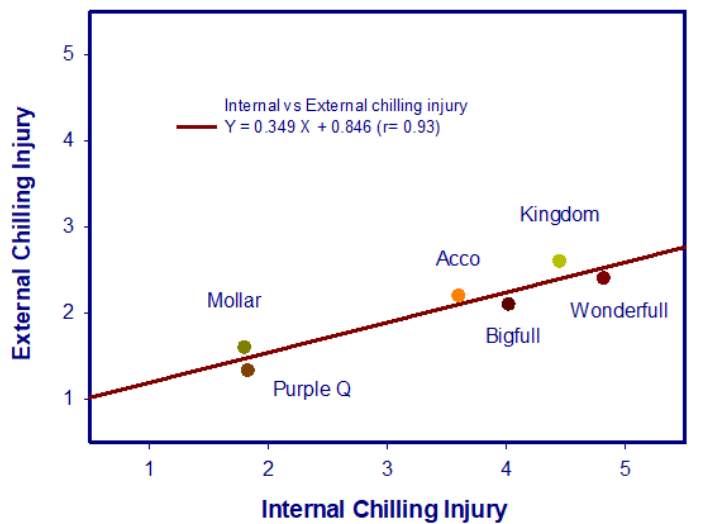
Figure 1. Symptoms of chilling injury on external and internal surface of skin in pomegranate culti- var after storage for 30 d at 2 °C plus 2 d at 20 °C.